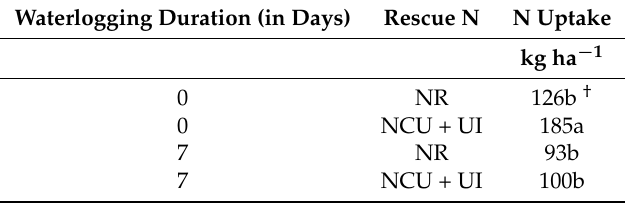
Table 7. Nitrogen uptake as affected by the interaction of waterlogging duration and rescue N in 2015. Waterlogging Duration (in